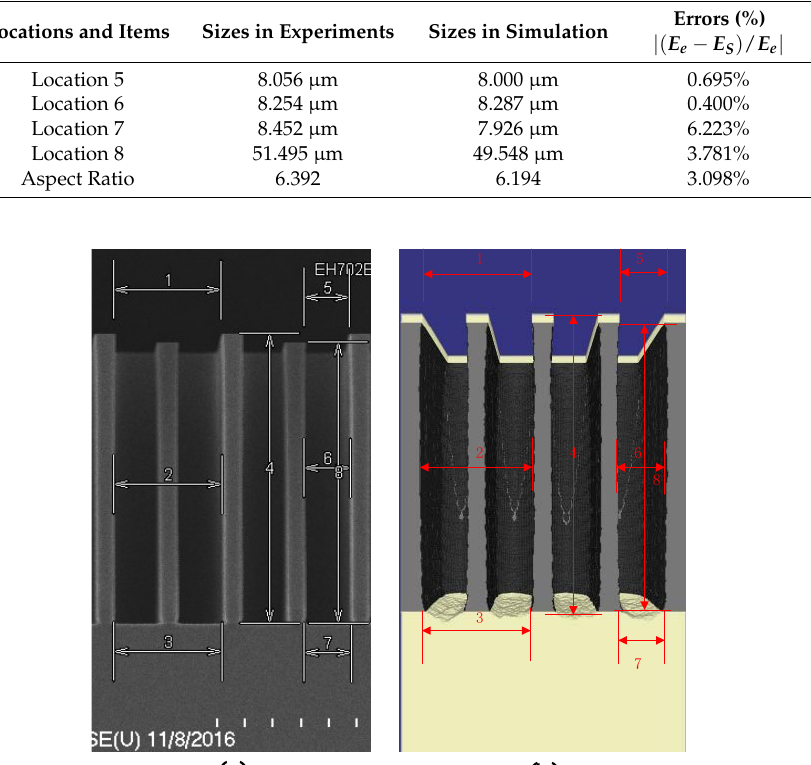
Figure 11. The experimental SEM photography ( a ) and simulation ( b ) of deep trenches in SOI structure.